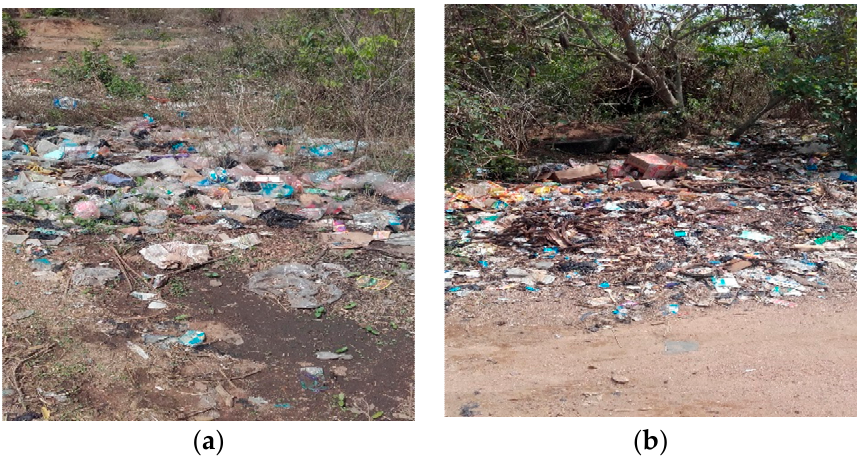
Figure 3. ( a ) Illegal dumping site showing waste composition; ( b ) another dumping site depicting waste composition.